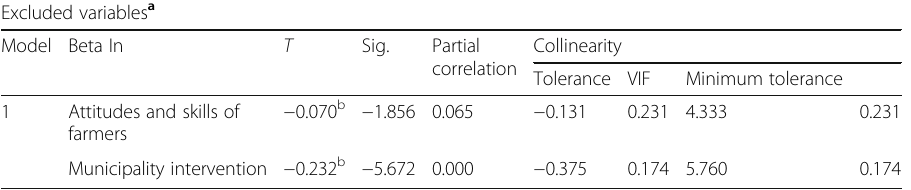
Table 4 The degree of impact of urbanization on livelihood of peri-urban farmers, excluded